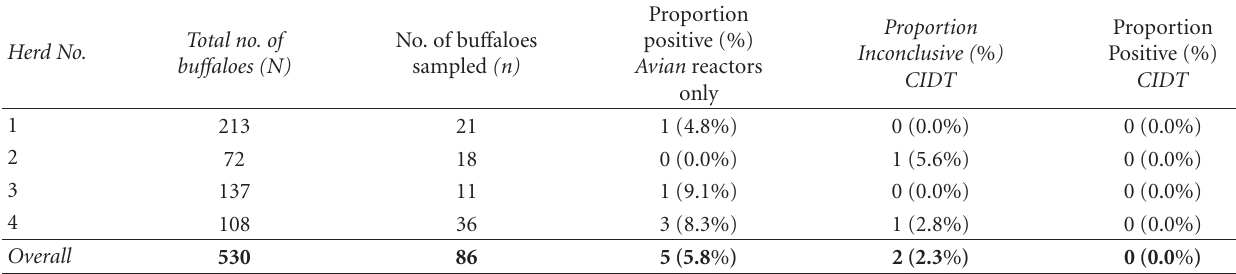
Table 1: Overall results based on Avian, Bovine and Comparative tuberculin test reactor animals.